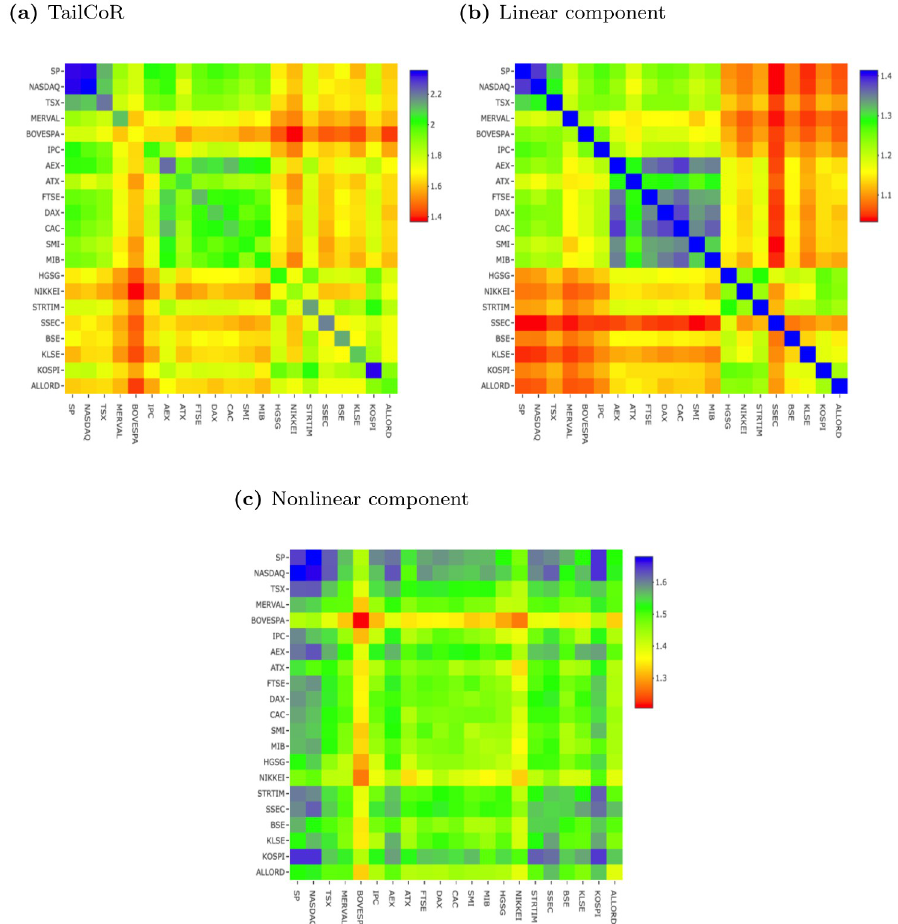
Fig 8. Full sample results—TailCoR and components. (a) TailCoR, (b) Linear component, (c) Nonlinear component.